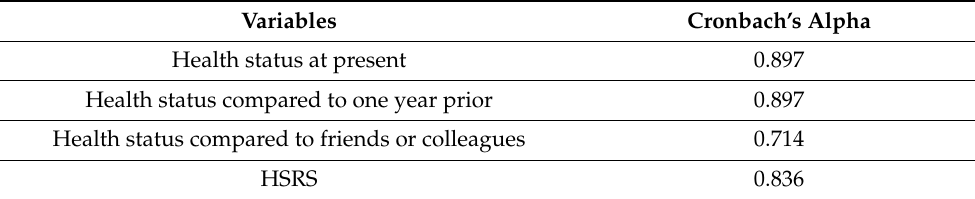
Table 3. Reliability of Health Self-Rating Scale